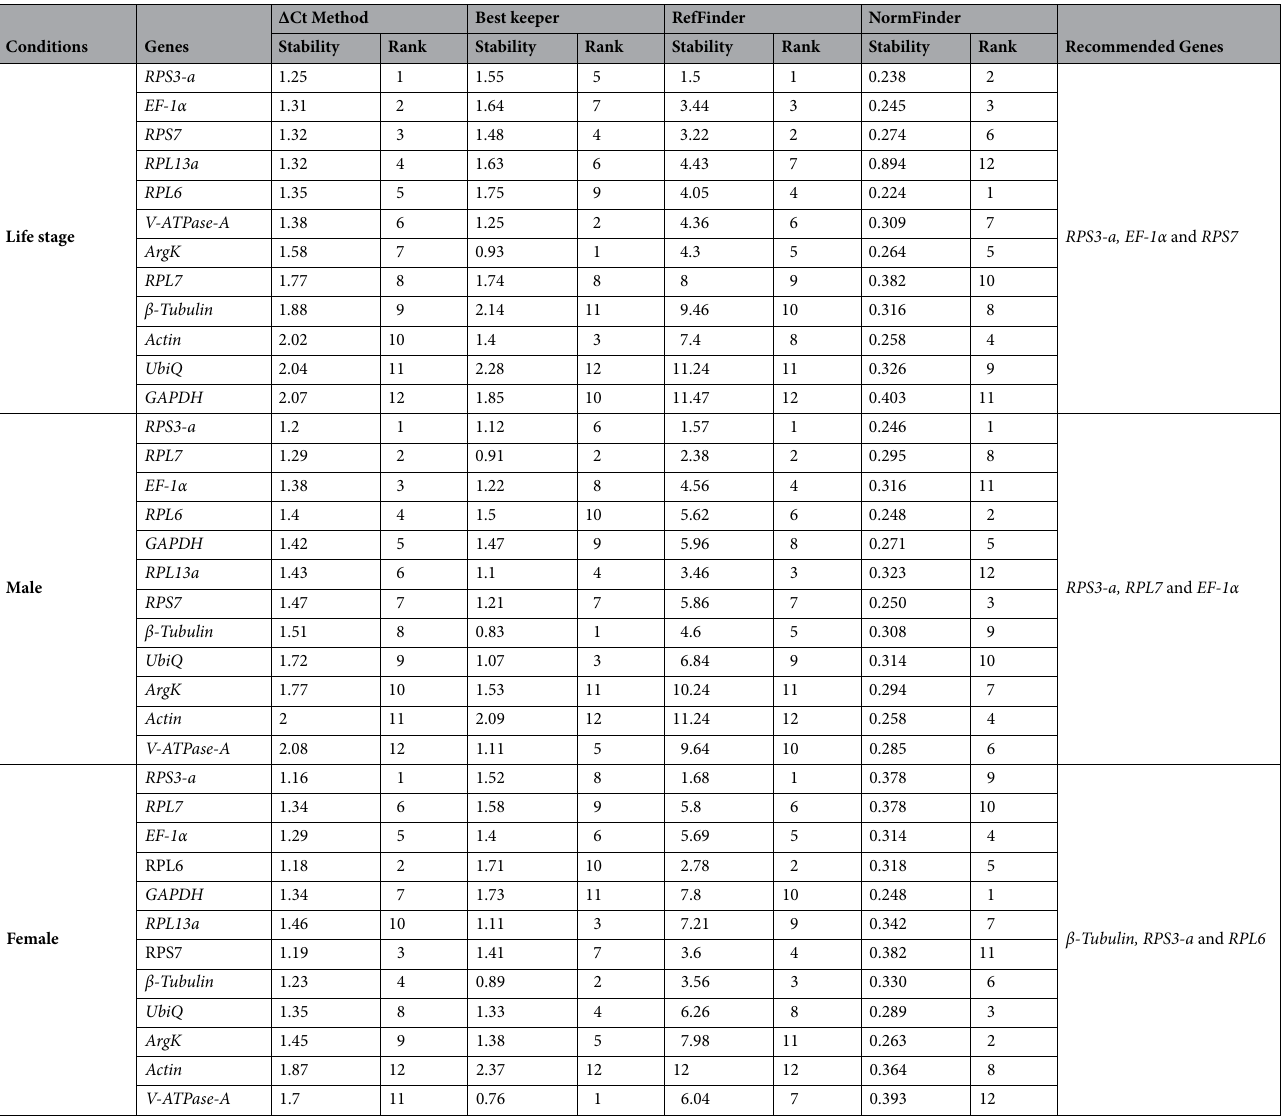
Table 3. Ranking of the candidate reference genes based on stability values performed by Delta Ct, BestKeeper, RefFinder, and NormFinder, in life stages (or developmental stages) and sex-specific